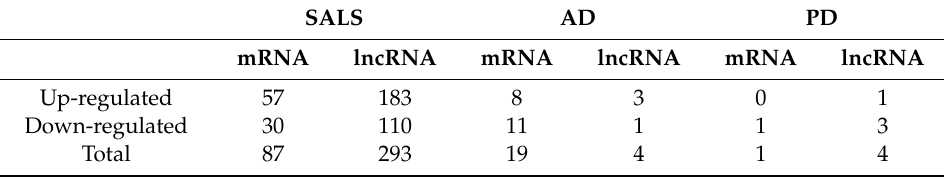
Table 1. Number of statistically significant di ff erentially expressed mRNAs and lncRNAs in PBMCs from SALS, AD and PD patients, in terms of up-regulated transcripts, down-regulated transcripts and total. SALS AD PD mRNA lncRNA mRNA